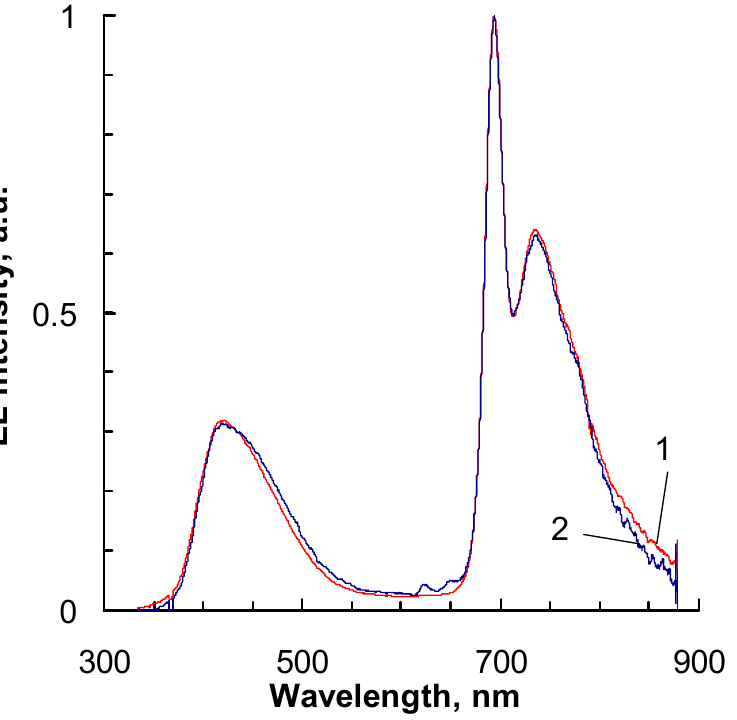
Figure 7. EL spectra at a temperature of 0 ◦ C: (1) before heating; (2) after cooling from 80 ◦ C. Since the sealed chamber of the Linkam cryostat does not allow placing in it an OLED with wires from a power source, we were unable to conduct a detailed analysis of the spectra at negative temperatures. However, we placed the OLED in a Horiba Dewar vessel with a transparent lower part and measured the phosphorescence spectra of the OLED when cooled to − 195 ◦ C (Figure 8). In the electroluminescence spectrum (Figure 8) measured at a voltage of 14 V, a low-intensity matrix emission band in the region of 400–500 nm and an intense Cu-EtioP spectrum are observed. The intensity ratio I 732nm /I 690nm = 0.31; it is also possible to note a close coincidence of the shape of the electroluminescence and photoluminescence spectra of Cu-EtioP at a temperature of − 195 ◦